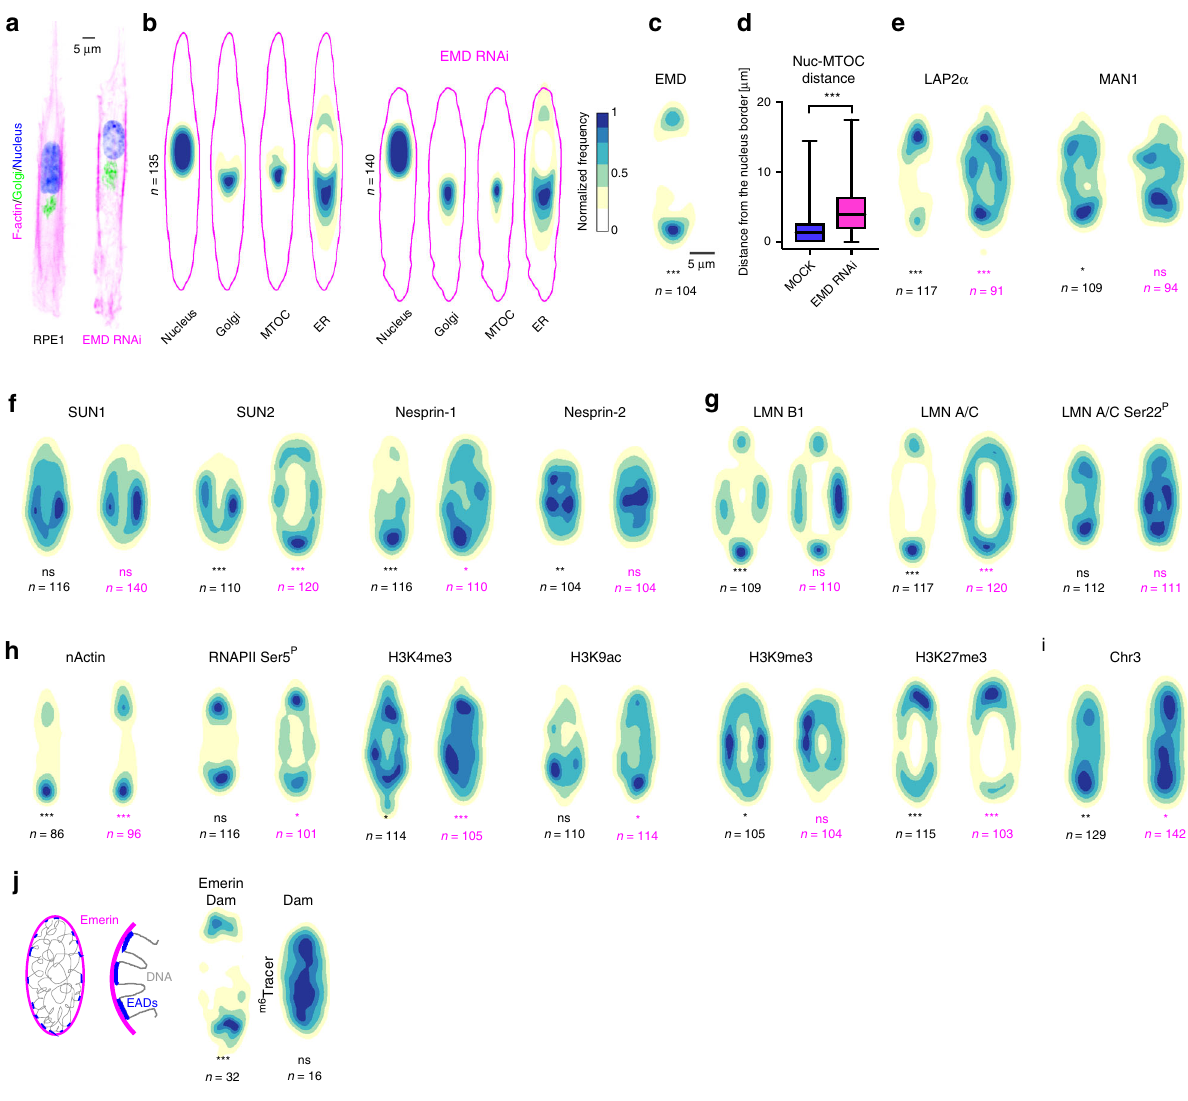
Fig. 2 Mapping the front-rear polarity in the nucleus. To facilitate the comparison, the distribution maps of control and EMD knock-down cells are presented next to each other. a Single control and EMD knock-down RPE-1 cells on 10 μ m micro-patterned lines. b Distribution maps of the nucleus, Golgi, MTOC, and ER in control (left panel) and EMD knock-down (right panel) cells. The magenta outline represents the F-actin border of the averaged cells. Normalized frequency color-coding used to prepare all the maps in the study. c Distribution map of EMD, P = 6 × 10 − 13 , two-sided Kolmogorov – Smirnov. d Distance between the border of the nucleus and MTOC, n MOCK = 135, n EMDRNAi = 140 cells from three independent experiments. The boxes represent the mean values and the line in the box represents median. Whiskers represent the minimum and maximum values. P = 2.3 × 10 − 12 , two-sided Kolmogorov-Smirnov test ( e ) Distribution maps of LEM domain-containing proteins in control (left, P Lap2 α = 9.1 × 10 − 11 , P MAN1 = 0.010 two-sided Kolmogorov – Smirnov) and EMD knock-down (right, P Lap2 α = 0.0004) two-sided Cramer – von Mises test) cells. f Distribution maps of LINC-complex proteins in control (left, P SUN2 = 8.6 × 10 − 6 , P Nesprin-1 = 1.9 × 10 − 9 , P Nesprin2 = 0.005 two-sided Kolmogorov – Smirnov test) and EMD knock-down (right, P SUN2 = 2.6 × 10 − 6 , P Nesprin-1 = 0.026, two-sided Cramer – von Mises test) cells. g Distribution maps of lamins (LMN), LMN A/C Ser 22 – Ser22 phosphorylated lamin A/C, in control (left, P LMNB1 = 1.4 × 10 − 11 , P LMNAC = 4.4× 10 − 16 , two-sided Kolmogorov – Smirnov test) and EMD knock-down (right, P LMNAC = 1.4 × 10 − 10 two-sided Cramer – von Mises test) cells. h Distribution maps of transcription-related markers, nActin — nuclear actin, RNAPII Ser 5 – Ser5 phosphorylated RNA polymerase II, in control (left, P nActin = 3.8 × 10 − 8 , P H3K4me3 = 0.011, P H3K9me3 = 0.030, P H3K27me3 = 0.00025, two-sided Kolmogorov – Smirnov test) and EMD knock-down (right, P nActin = 3.9 × 10 − 6 , P RNApolSer5 = 0.042, P H3K4me3 = 2.9 × 10 − 11 , P H3k9ac = 0.015, P H3K27me3 = 0.00023, two-sided Cramer – von Mises test) cells. i Distribution map of chromosome 3 in control (left, P = 0.007 two-sided Kolmogorov – Smirnov test) and EMD knock-down (right, P = 0.013 two-sided Cramer-von Mises test) cells. j Graphical representation of the DamID technique (left) that serves to mark emerin-associated domains (EADs). Distribution maps of Emerin-Dam and Dam protein alone, P = 7.5 × 10 − 5 , two-sided Kolmogorov – Smirnov test. *** P < 0.001, ** P < 0.01, * P < 0.05, ns — not signi fi cant. For each distribution map an exact number of cells from three independent experiments is stated in the fi gure. Source data are provided as Source Data fi